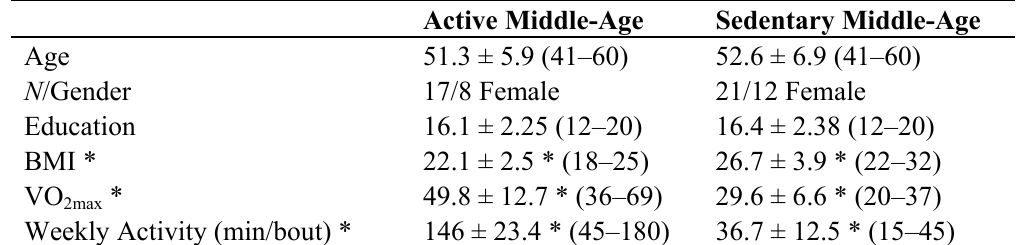
Table 1. Participant characteristics—Mean ± SD